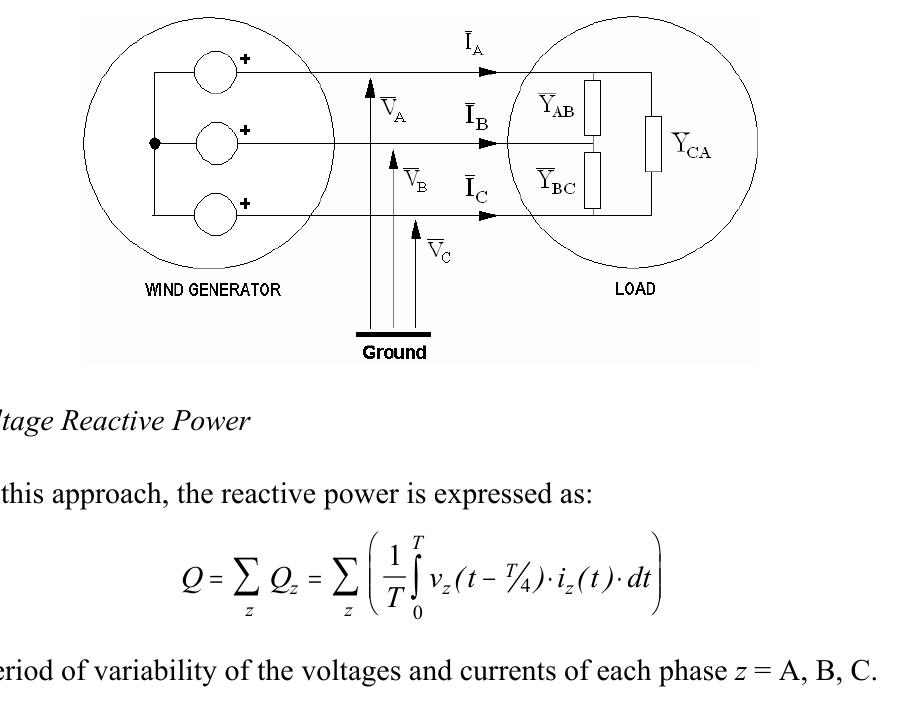
Figure 3. Wind generator and load at net interconnection